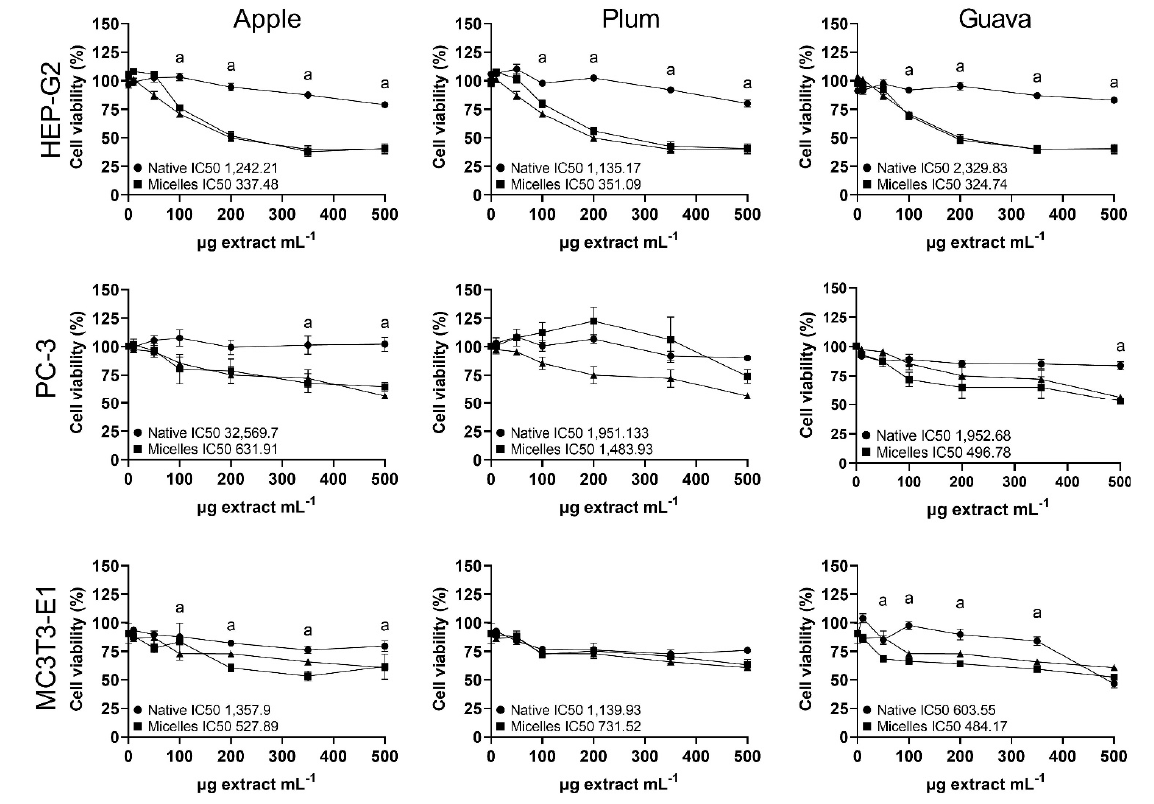
Figure 4. Percentage (mean ± SEM, n = 3) cell viability (neutral red assay) in Hep-G2 (human hepatocellular carcinoma), PC-3 (human prostatic adenocarcinoma), and MC3T3-E1 (murine pre-osteoblast fibroblasts) treated for 24 h with native (circled lines) and micellar (squared lines) formulations of apple peel ( Malus domestica cv. Anna), whole plum ( Prunus domestica cv. Satsuma), or whole guava ( Psidium guajava L). Lines with triangles show the effect of equivalent amounts of the empty micelle formulation on the cells. IC 50 (the concentration of the sample required to inhibit neutral red response to 50% respective to the untreated control) is shown as μ g extract mL − 1 . Statistical differences between native and micellar formulations within cell lines were determined by one ‐ way ANOVA, followed by Bonferroni´s multiple comparison post ‐ hoc tests, and they are indicated by